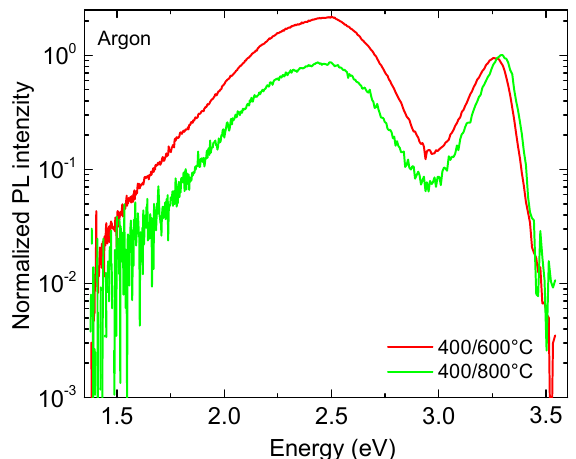
Figure 8. Room temperature photoluminescence spectra of the seed layer preheated and annealed in argon at different temperatures: red line 400 °C/600 °C; green line 400 °C/800 °C.